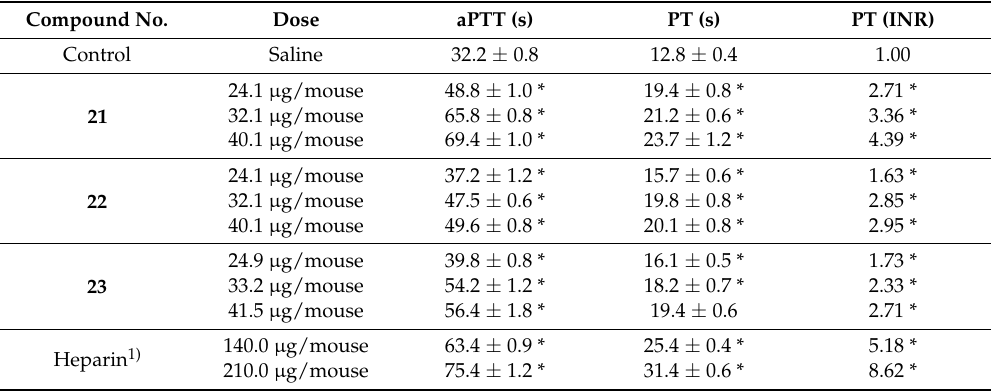
Table 8. Ex vivo clotting time of amidino N 2 -thiophene compounds 21 – 23 .